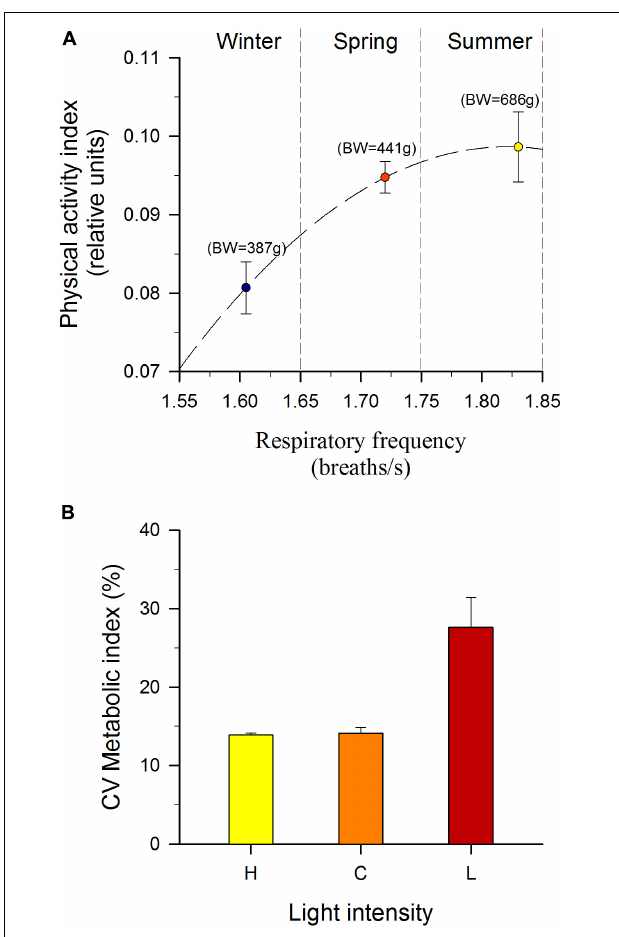
FIGURE 6 | (A) Seasonal correlation plot between physical activity index and respiratory frequency in cultured gilthead sea bream (measures taken every 15 min along 2 days). Each value represents the mean mesor of 10–12 individuals (B) Coefficient of variation (CV) of the metabolic index (respiratory frequency/physical activity) of Atlantic salmon exposed to different light intensities: H (High, yellow bar, 18.90 µ mol.m − 2 .s − 1 ), C (Control, orange bar, 6.83 µ mol.m − 2 .s − 1 ) and L (Low, red bar, 0.28 µ mol.m − 2 .s − 1 ). Each value is the mean ± SEM of the daily coefficient of variation of 6–7 individuals for 3 days. Different letters indicate significant differences ( P < 0.01, ANOVA). Partially adapted from data of Kolarevic et al.